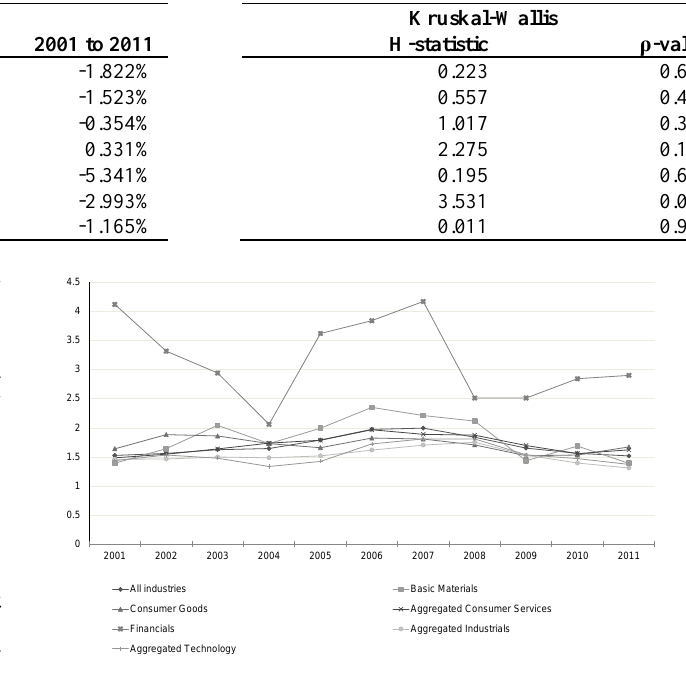
Figure 2: Movement in human capital efficiency per